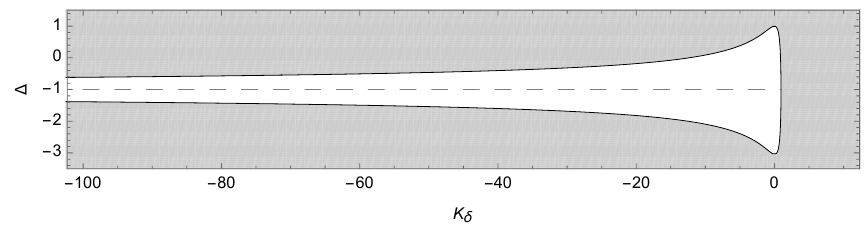
Figure 1 . Allowed parameter space as a function of (cid:1) and K (cid:14) for (cid:18) = 0 :